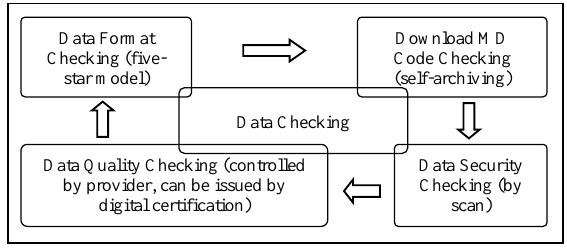
Figure 5. data checking